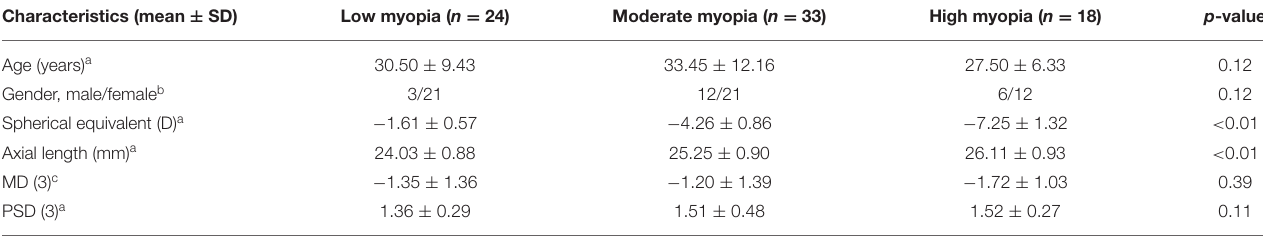
TABLE 1 | Characteristics of the high, moderate, and low myopia groups.